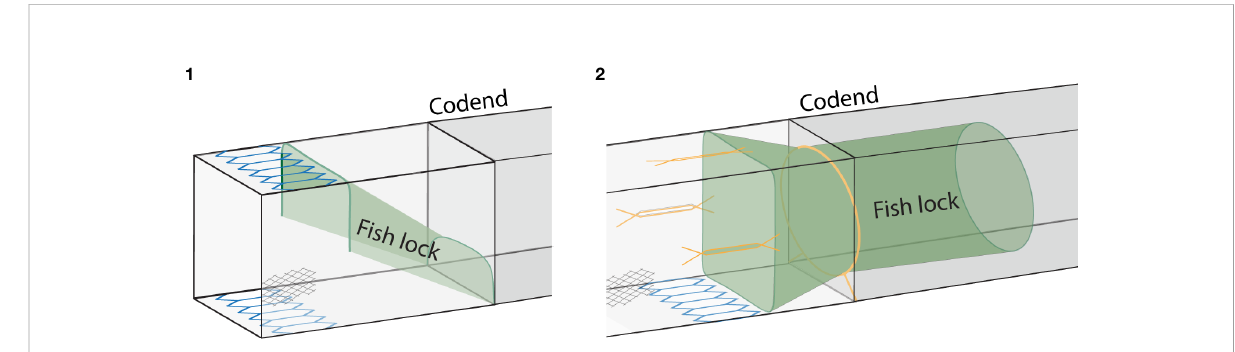
FIGURE 3 (1) fi sh lock consisting of an inclined net panel (Type 1, left); (2) fi sh lock consisting of a cylindrical net (Type 2,